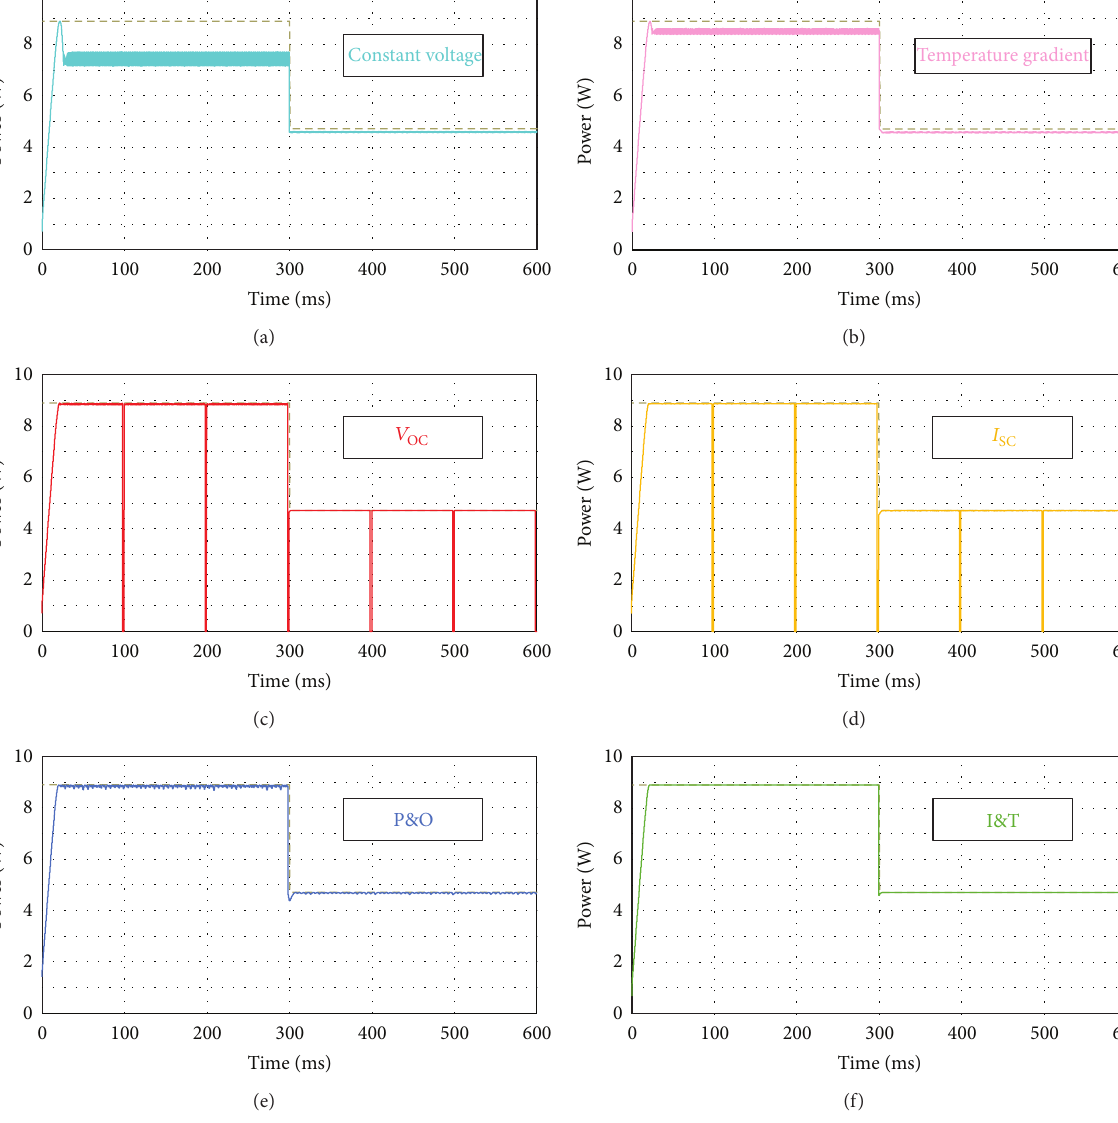
Figure 13: Tracking efficiency of MPPT techniques (1000W/m 2 to 500 W/m 2 and 65 ∘ C to 25 ∘ C): (a) constant voltage; (b) temperature gradient; (c) open-circuit voltage; (d) short-circuit current; (e) P&O; (f)